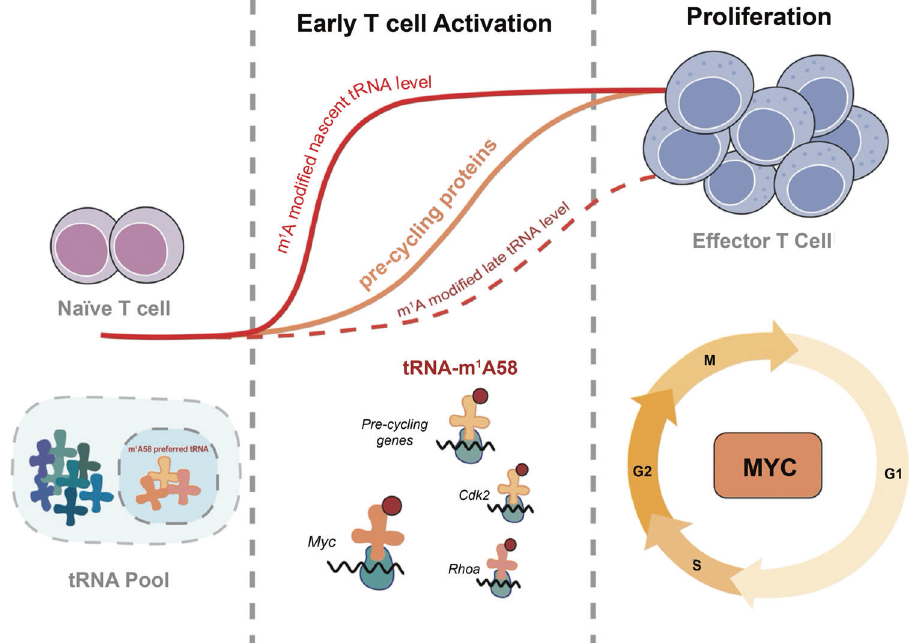
Fig. 1 TRMT61A-mediated tRNA-m 1 A58 modi fi cation serves as a novel “ translation checkpoint ” for CD4 + T-cell proliferation. In the stage of early T-cell activation, ef fi cient translation control is activated by TRMT61A/TRMT6-mediated tRNA-m 1 A58 modi fi cation on a subset of early upregulated tRNA to enable synthesis of MYC and of a speci fi c group of key functional proteins, which is required to promote rapid T cell into cell cycles and